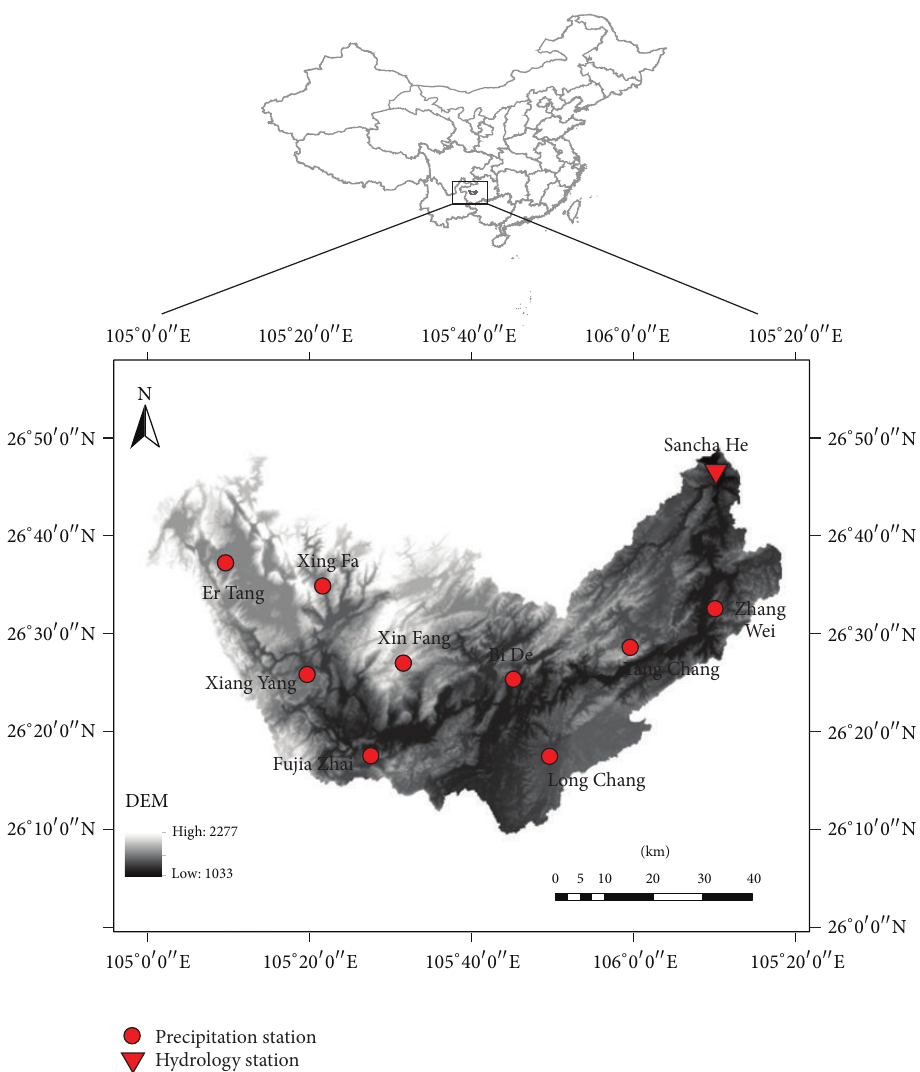
Figure 1: Location of Sancha River